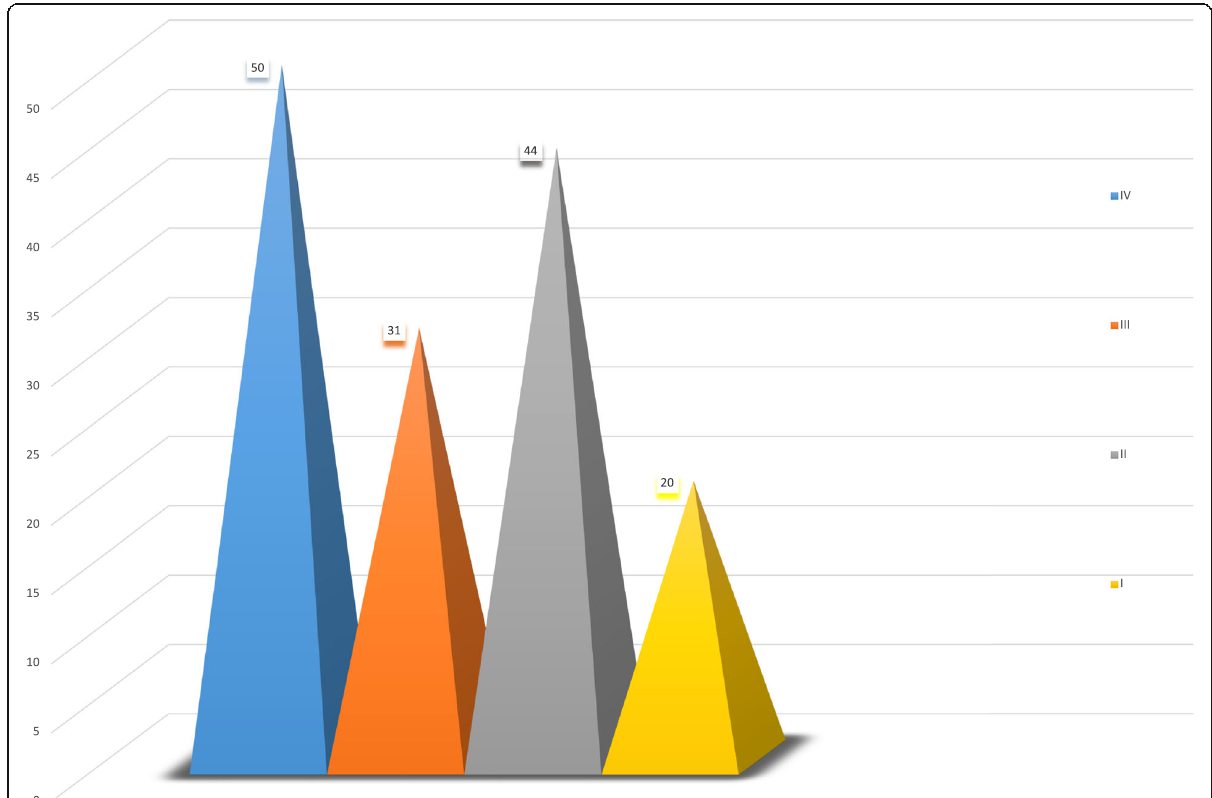
Fig. 2 Ann Arbor stage of lymphoma cases